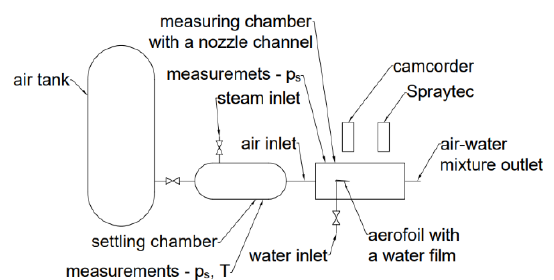
Fig. 2. Measurement schema of the wind tunnel. The used camera XIMEA MC050CG-SY contains color CMOS digital image sensor Sony IMX250 LQR- C. The sensor has 2464x2056 active pixels and 3,45 µm pixel pitch.